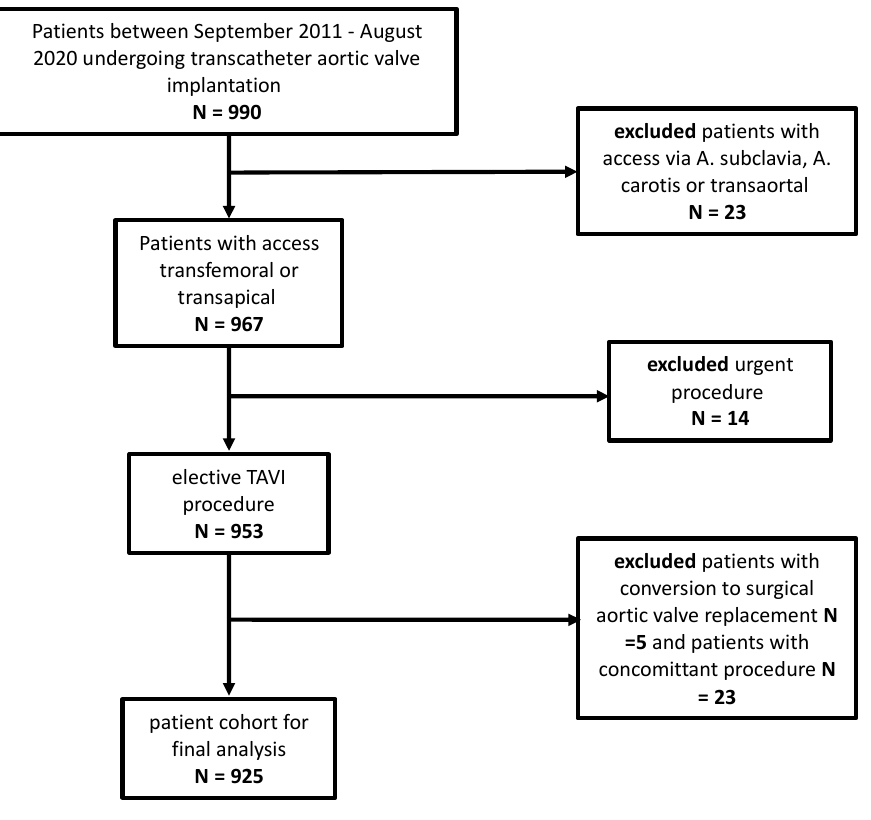
Figure 1. Figure 1. Flowchart.